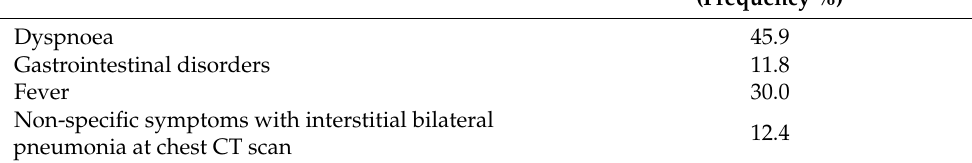
COVID-19 Prospective Cohort (mean ±